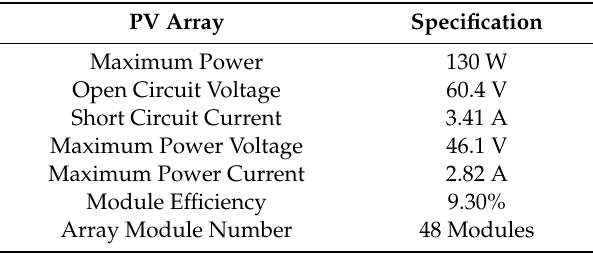
Figure 2. Installation setup of photovoltaic (PV) modules. Table 1. Specifications of the PV system.